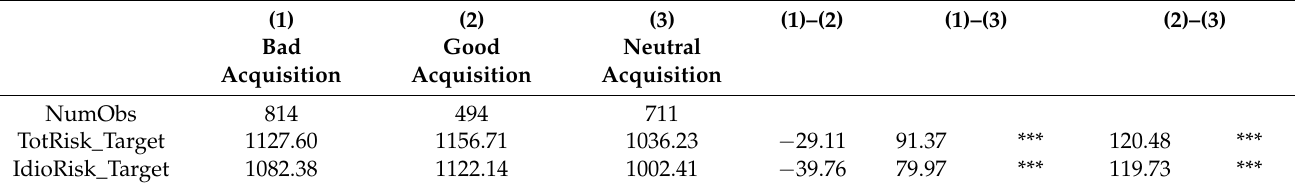
Table 5. Target firm risk prior to acquisitions. This table presents the comparison of the target firm’s risk profile prior to acquisition announcements of our sample of M&As. TotRisk_Target is the annualized standard deviation of daily stock returns, which are measured during the three years prior to the acquisition announcement. IdioRisk_Target is the annualized standard deviation of daily residual stock returns, which are measured during the three years prior to the acquisition announcement. *, **, and *** denote statistical significance at the 10%, 5%, and 1% levels,